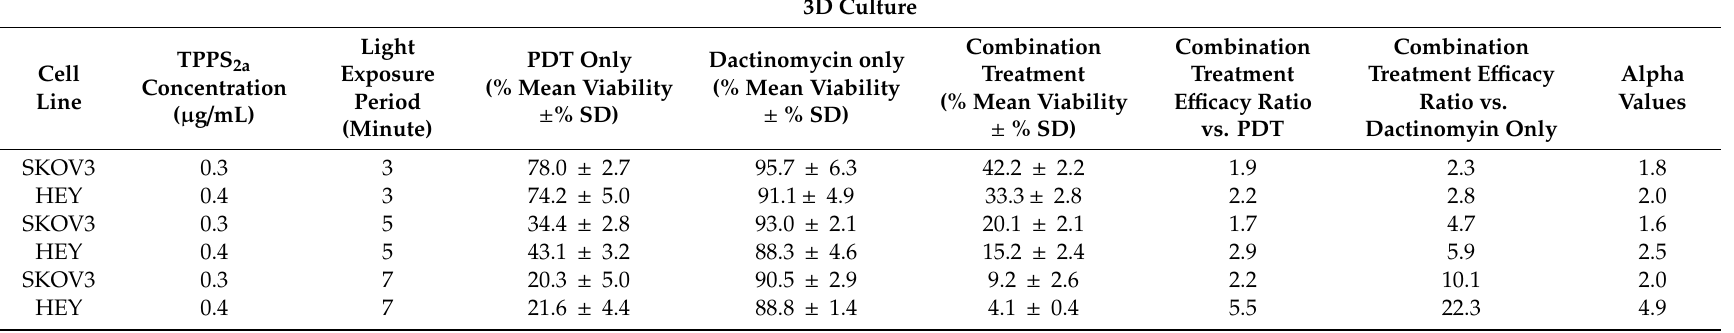
Table 2. Summary of percentage viabilities ± % SD, combination treatment e ffi cacies and alpha values in 3D cultures of SKOV3 and HEY cells. The concentration of Dactinomycin used was 1 nM. The cells were incubated for 48 h post light exposure before terminating the experiment. The measurements were obtained with Alamar Blue